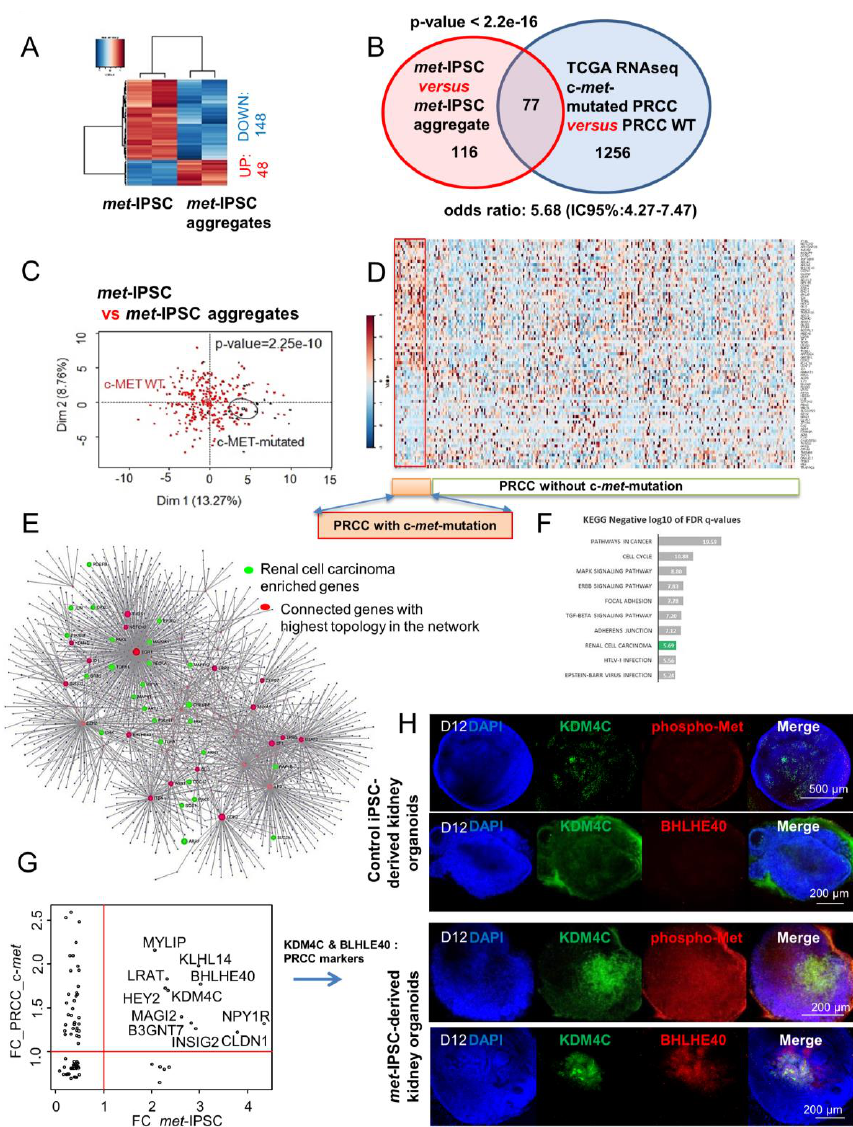
Figure 6. Transcriptome analyses of met -IPSC aggregates. ( A ) Expression heatmap (Euclidean distances) of differential expressed genes found between met -IPSC (monolayer culture) and met -IPSC aggregates. ( B ) Venn diagram of the meta-analysis between met -IPSC and PRCC patient analysis, p -value of the met -IPSC signature in PRCC expression profile was calculated by hypergeometric test of Fisher. ( C ) Principal component analysis performed with meta-analysis gene intersection (77 genes) on PRCC tumor samples (Z-scores RNA-seq V2), p -value was calculated by correlation of the group discrimination of the first principal component. ( D ) Expression heatmap performed with meta-analysis gene intersection (77 genes) on PRCC tumor samples. ( E ) protein-protein interaction network built with the projection of 77 meta-analysis genes on innateDB interaction database: red genes represent connected genes with the highest topology in the network, green genes represent enriched gene during Kyoto Encyclopedia of Genes and Genomes (KEGG) inference and related to the Renal cell carcinoma. ( F ) Bar plot representing negative logarithm base 10 of False Discovery Rate (FDR) q-values found during functional inference of KEGG database on meta-analysis protein-protein interaction (PPI) network. ( G ) Concordance scatterplot of fold-change (FC) found during meta-analysis of transcriptome. The x-axis shows FC of the genes found in met -IPSC transcriptome study and the y-axis shows the FC of genes found in analysis of PRCC RNA-seq study. The genes found to be expressed > 1 FC are shown by their gene symbols. ( H ) Whole-mount immunostaining for KDM4C (Lysine demethylase 4C), phospho-Met and DAPI in kidney embryoid